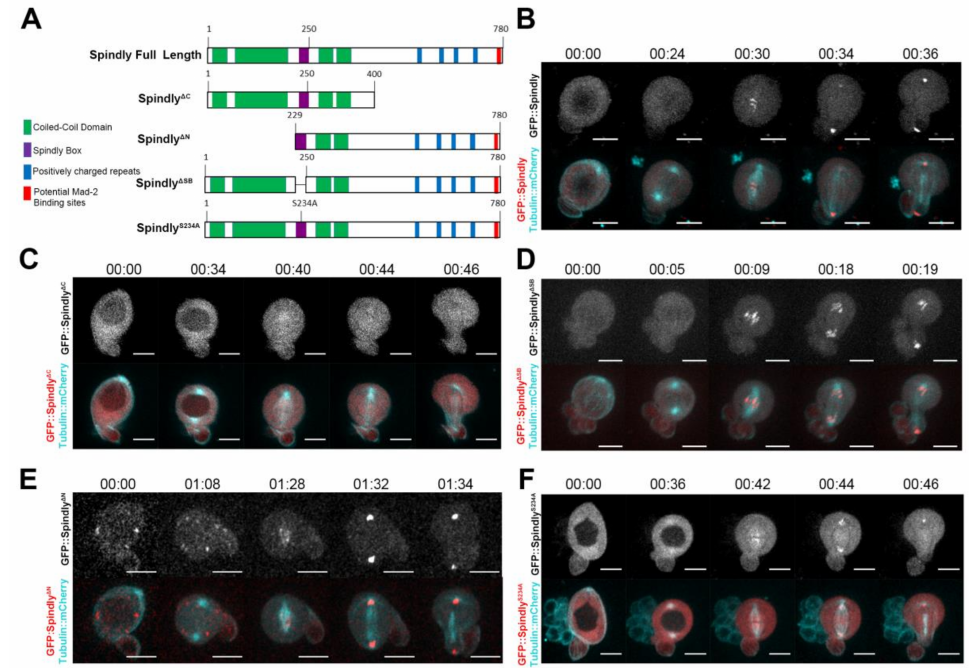
Figure 1. Identification of Spindly protein domain(s) required for dynamic localisation in mitosis. ( A ) Schematic drawing showing the full-length Drosophila Spindly protein and mutant constructs generated in this study. Spindly is a predicted coiled-coil domain containing protein (N-terminal half, in green) characterised by a positively charged C-terminal domain (in blue). The highly conserved repeat motif is depicted (Spindly box, in purple). Spindly localises to the outer kinetochore plate by interacting with the RZZ complex through its C-terminal domain [30–33]. In addition to the importance of the C-terminal half, other regions of the protein contribute to kinetochore targeting. Human Spindly requires the first coil-coiled domain, the Spindly box and a region between residues 440–564 for kinetochore binding [30]; ( B – F ) Representative examples of dividing neuroblasts overexpressing the indicated UAS >>[Green Fluorescent Protein (GFP)]::Spindly variants under the control of the worniu >Gal4 driver; ( B ) GFP::Spindly full length gets recruited to kinetochores at early pro-metaphase (00:26) and can be seen moving from KT to poles at anaphase (00:32). In all cases ( n = 21) the protein localised this way; ( C ) GFP::Spindly ∆ Ct never localised at kinetochores throughout mitosis ( n = 43). Mutant constructs deleted of the Spindly box (GFP::Spindly ∆ SB ) ( n = 21) ( D ); N-terminal half ( n = 40) ( E ) or a point mutant S234A (GFP::Spindly S234A ) ( n = 33) ( F ) showed a localisation dynamics similar to the full-length protein. Note the speckled pattern of GFP::Spindly ∆ Nt in interphase, which was observed in 31/40 cases. The minor differences between the distribution of the full length GFP::Spindly and the GFP::Spindly ∆ SB ( D ) or GFP::Spindly S234A ( F ) proteins are due to small variations in the expression of the wor > Gal4 driver and slight differences in the time resolution of the still images; for a full comparison, we refer to the respective movies. Time stamp: hh:min. Scale bars: 10 µ